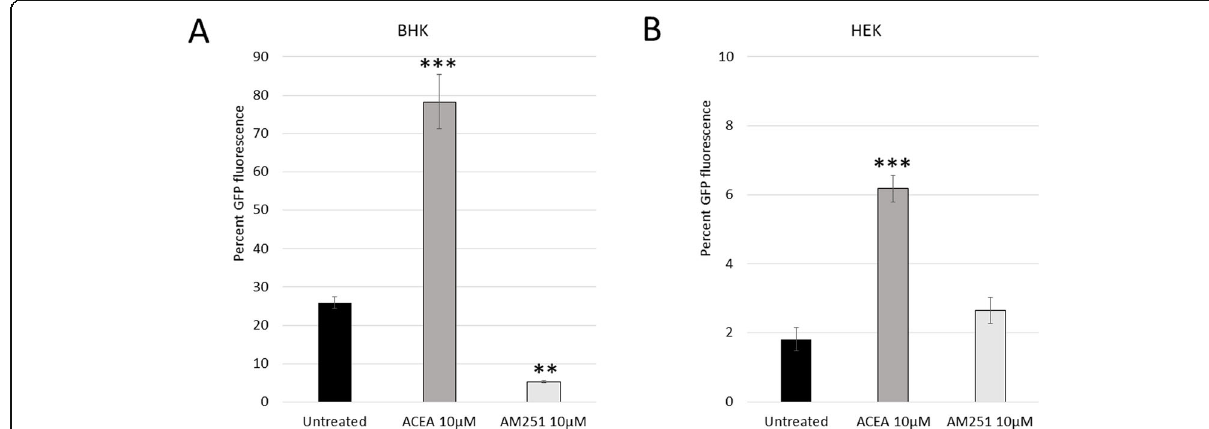
Fig. 4 Confirmation of ACEA/AM251 treatment on SINV-infected baby hamster kidney (BHK) and human embryonic kidney (HEK) cells. Results from flow cytometry analysis of individual cells. Confirms results in Fig. 3 with two additional cell